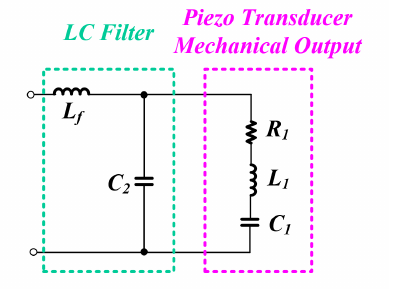
Figure 5. Impedance separation of the LC filter and PT RLC series